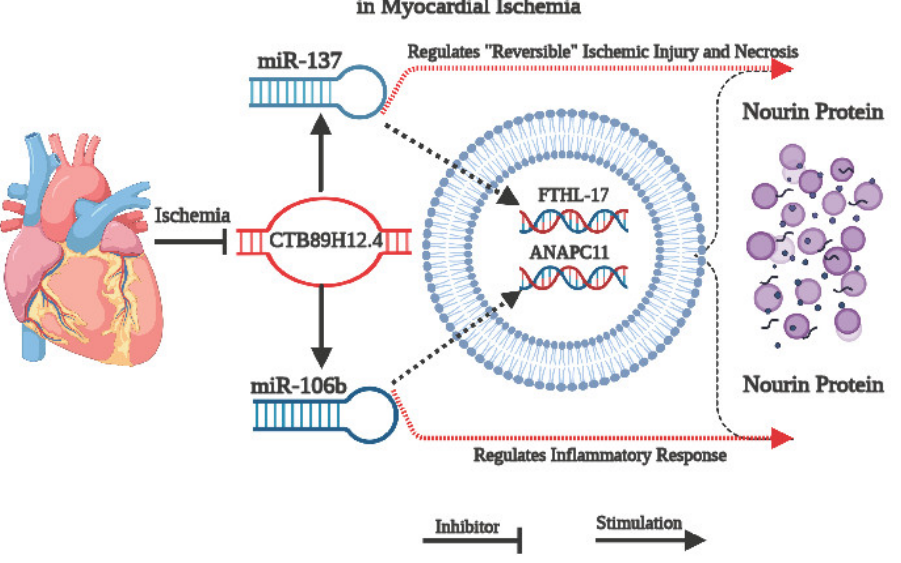
Figure 2. Schematic diagram illustrating the mechanism of Nourin-dependent miRNAs, miR-137 and miR-106b-5p , in myocardial ischemic injury and their associated molecular network, based on integrative bioinformatics analysis. Downregulation of CTB89H12.4 due to ischemia resulted in upregulation of both miR-137 (marker of cell damage) and miR-106b-5p (marker of inflammation) and activation of mRNA-FTHL-17 and mRNA-ANAPC11 , with a likely increased translation and production of Nourin protein.